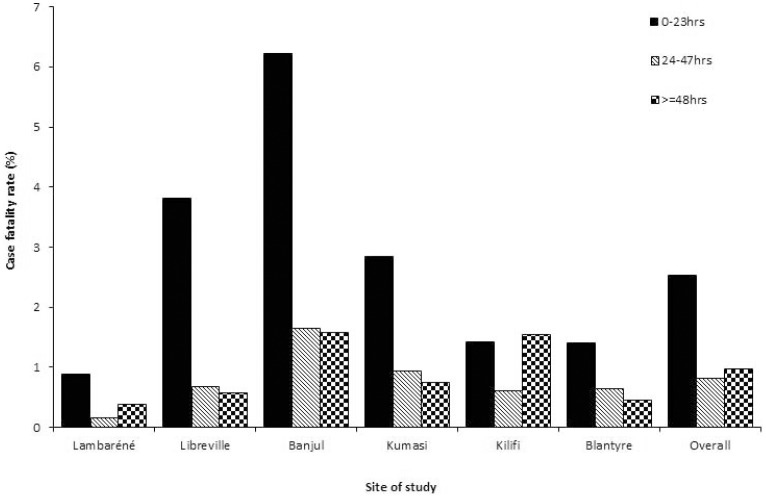
Bar graph showing the case fatality rate of severe falciparum malaria in 6 groups classified by time to death after admission.Case fatality rate was not similar in a time group and within a site (p<0.001). Case fatality rate significantly decreased with time in all sites except in Lambaréné and Kilifi.